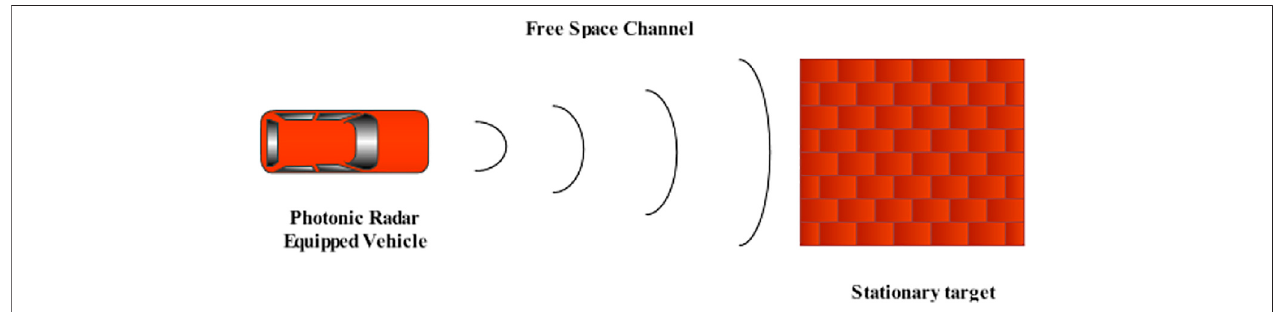
FIGURE 1 | Vehicle to stationary target (vehicle)